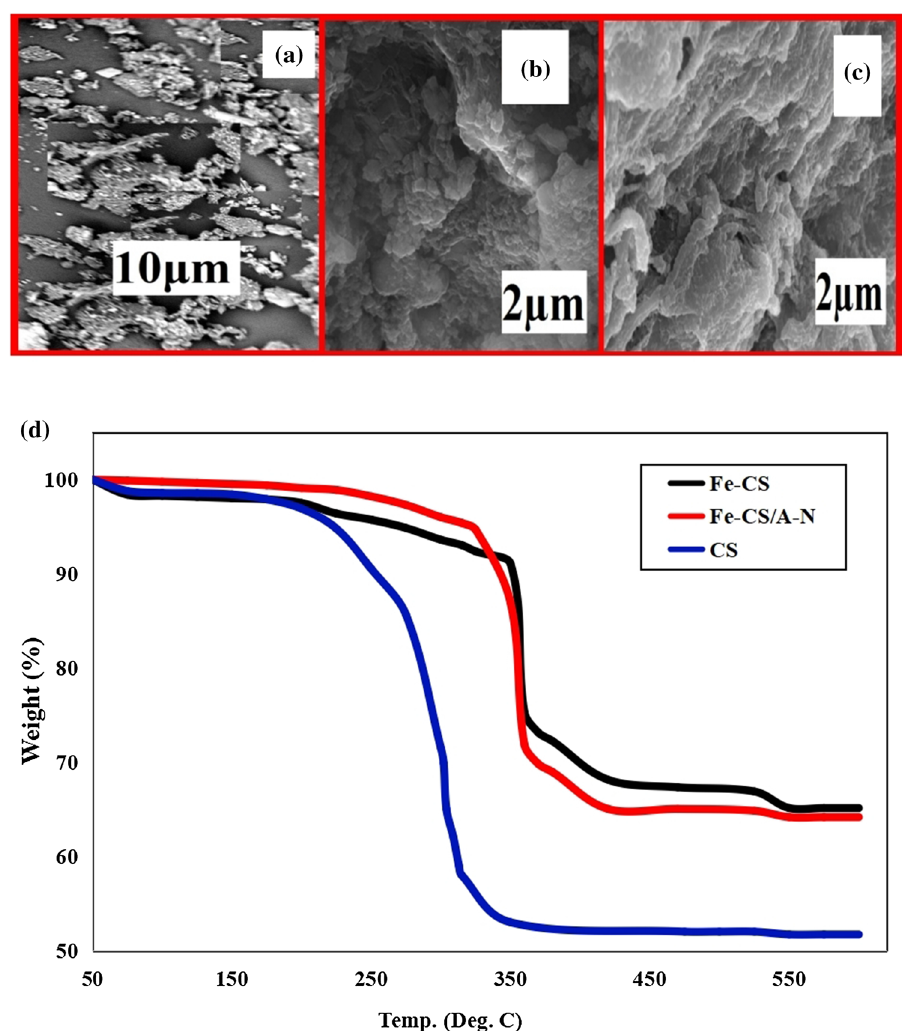
Fig. 3 SEM micrograph for